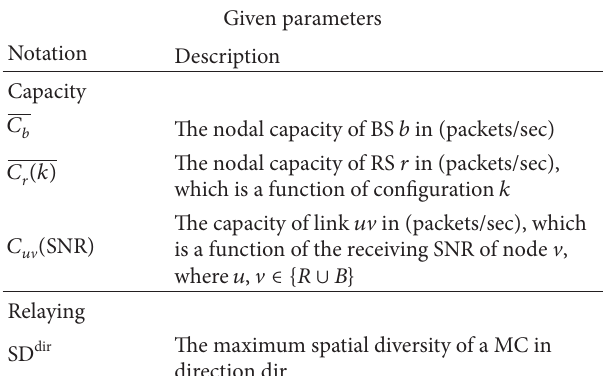
Table 1: Notations of given parameters. Table 1: Continued.